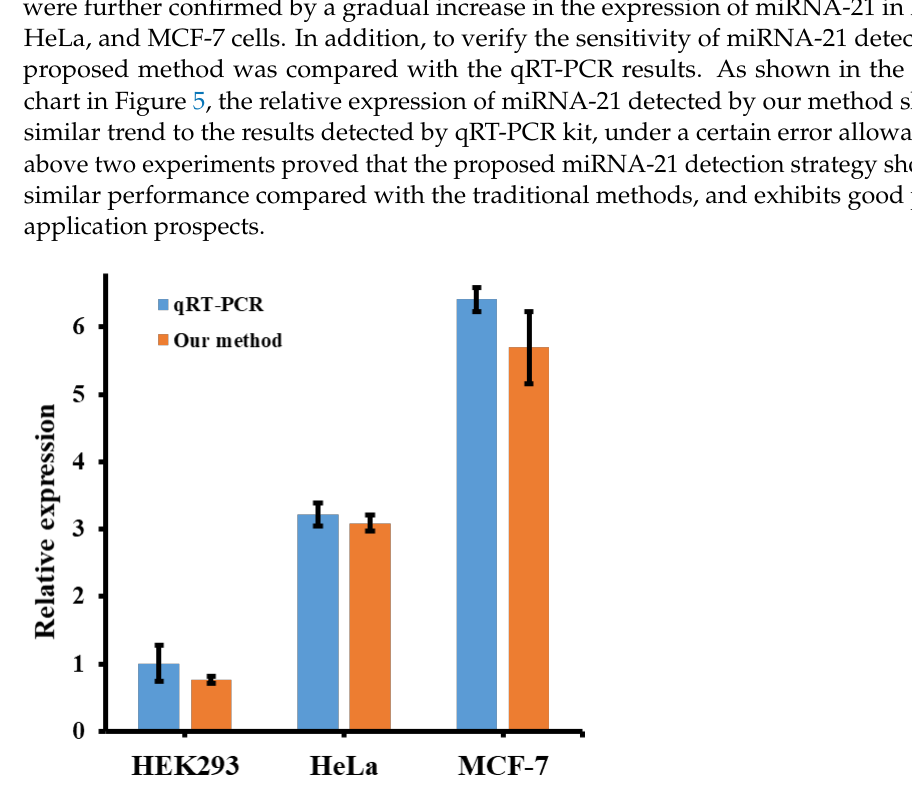
Table 2. Experimental recovery results of human serum samples ( n = 3).